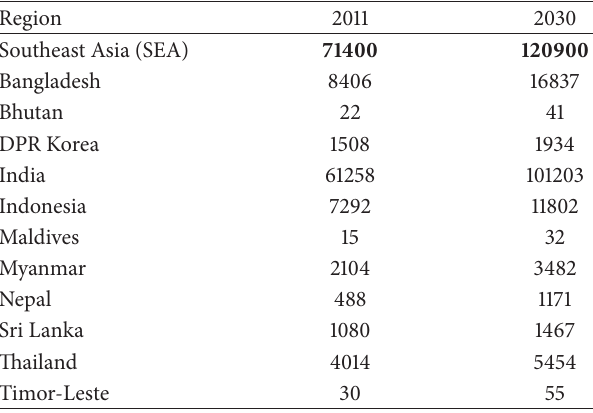
Table 1: Number of people with diabetes (in thousands) in the